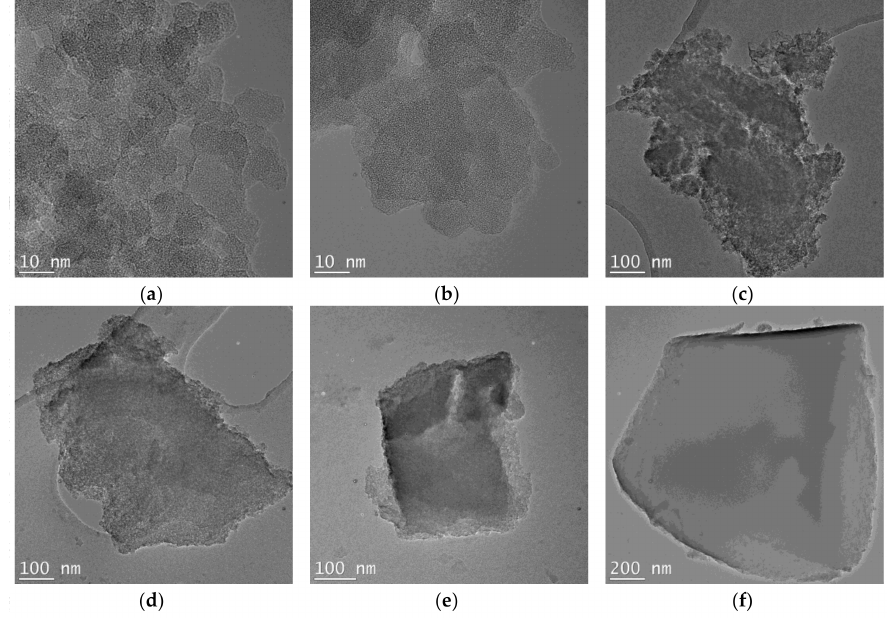
Figure 6. TEM micrographs of the hybrid silica-gels using different amount of vinyl substituents (( a ) B00-VTAS, ( b ) B05-VTAS, ( c ) B05-VTAS, ( d ) B20-VTAS, ( e ) B40-VTAS, ( f )